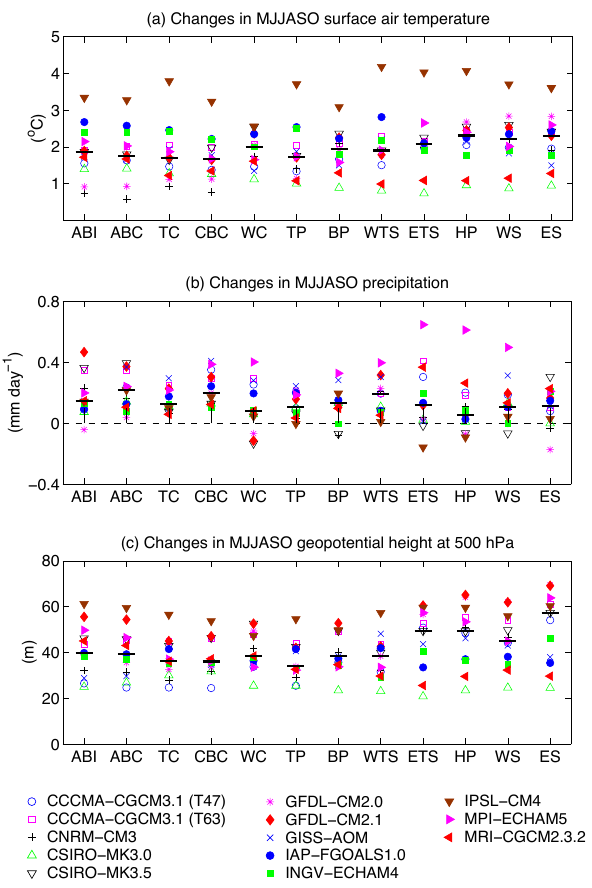
Figure 6. Calculated changes in (a) surface air temperature, (b) precipitation, and (c) geopotential height at 500hPa during the fire season (May–October) in 2048–2064 relative to 1983–1999. Results are from an ensemble of GCMs for the A1B scenario. The ecoregions are: Alaska Boreal Interior (ABI), Alaska Boreal Cordillera (ABC), Taiga Cordillera (TC), Canadian Boreal Cordillera (CBC), Western Cordillera (WC), Taiga Plain (TP), Boreal Plain (BP), Western Taiga Shield (WTS), Eastern Taiga Shield (ETS), Hudson Plain (HP), Western Mixed Wood Shield (WS), and Eastern Mixed Wood Shield (ES). Different symbols are used for each model. The black bold lines indicate the median changes.